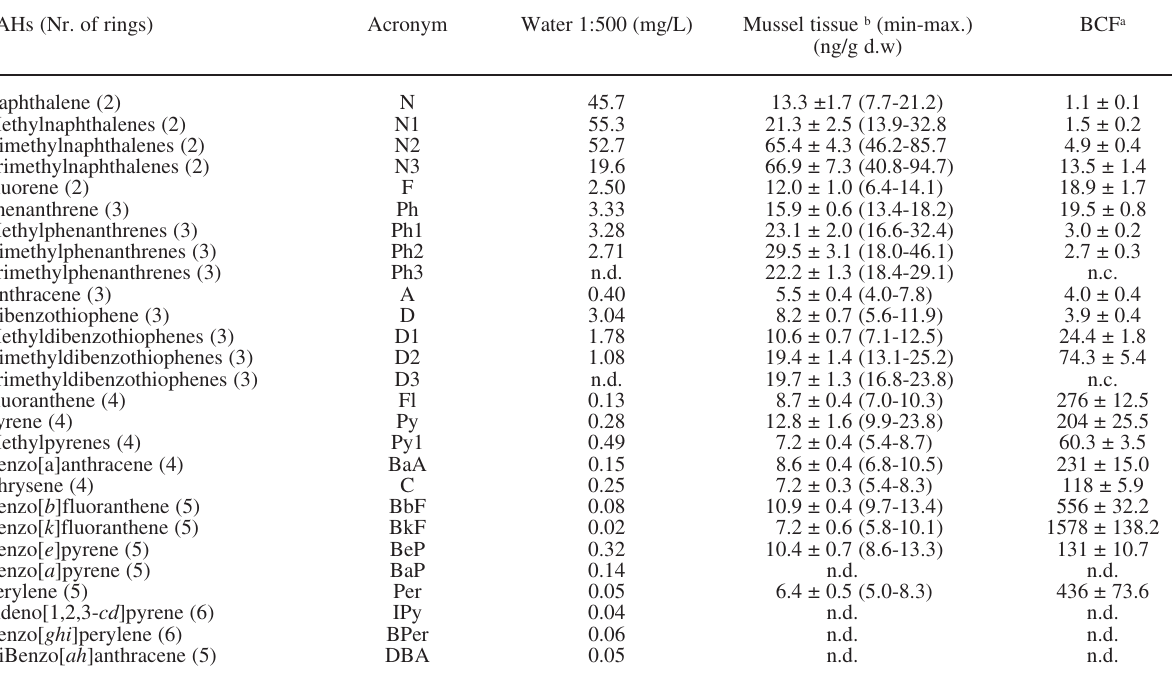
T ABLE 1. – Concentration of PAHs in the WAF used for the experiment and mean mussel tissue concentration during the experiment (considering control and exposed tanks at all time exposures) and the corresponding bioconcentration factors (BCF). PAHs (Nr. of rings)